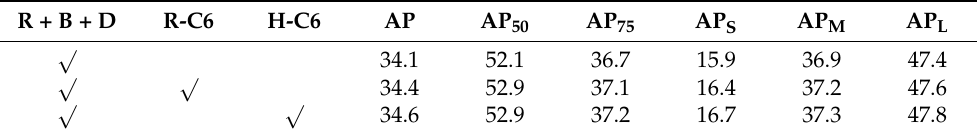
Table 4. Ablation studies of Dilated Feature Enhancement on COCO val-2017. B + R + H: RetinaNet + BidiFPN +